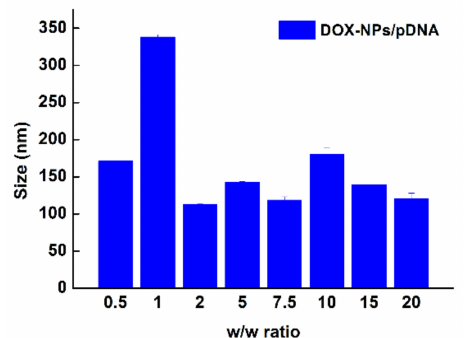
Figure 3. Particle size of DOX-NPs/pDNA complexes at different w / w ratios.